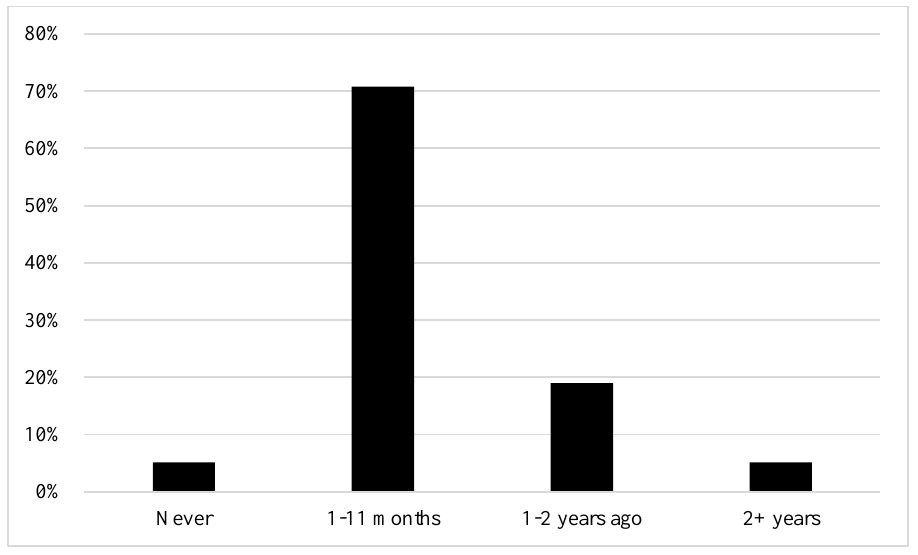
Figure 1 . Percentage of students who previously purchased a textbook. Data indicate that faculty members were aware of the importance of cost and more than 71% of the faculty members in our study checked textbook prices within the past 11 months (Figure 2).